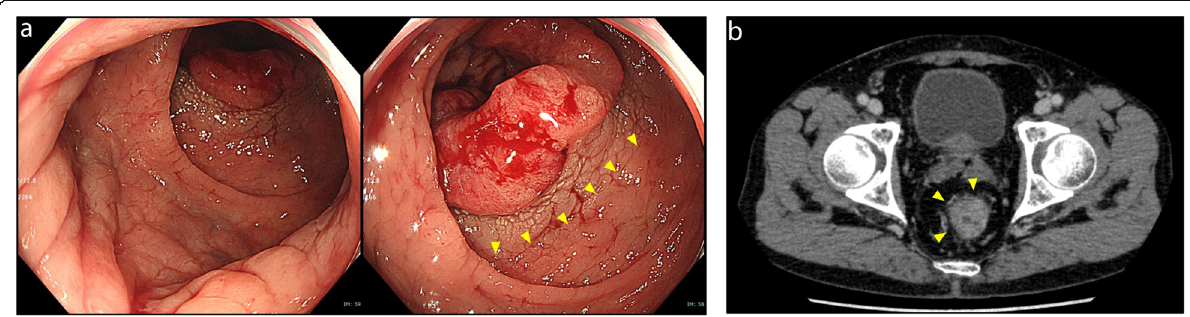
Fig. 1 Preoperative evaluation of the patient. a Colonoscopy revealed a tumor 7 cm above the anal verge. Yellow arrowheads show edematous epithelium at the distal side of the tumor due to the ALTA sclerotherapy. b CECT showed thickening of the rectal wall in the lower rectum (yellow arrowheads)